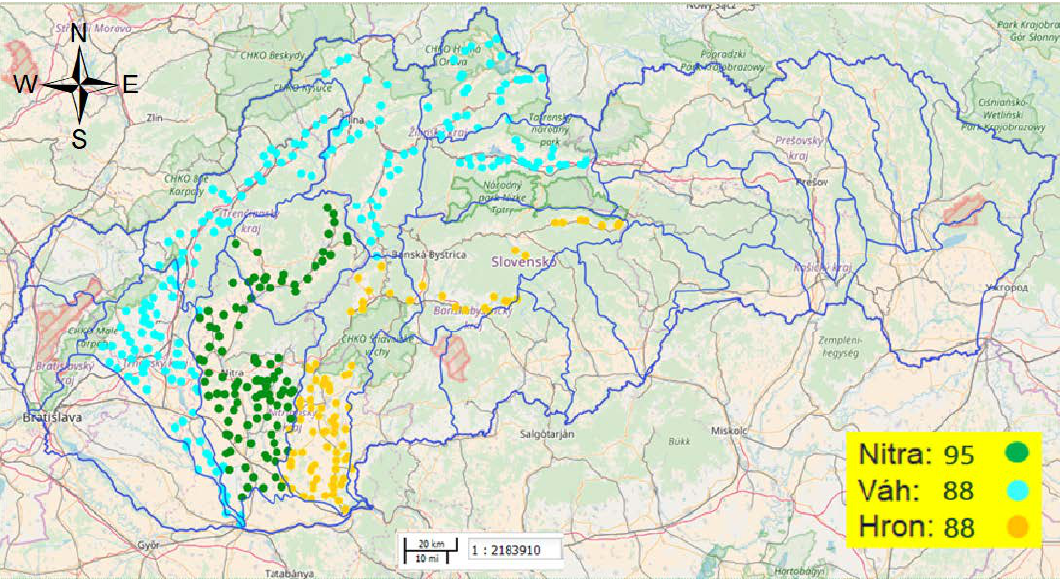
Figure 1. Location and the number of sampling sites in the Nitra, Váh, and Hron River basins [52].